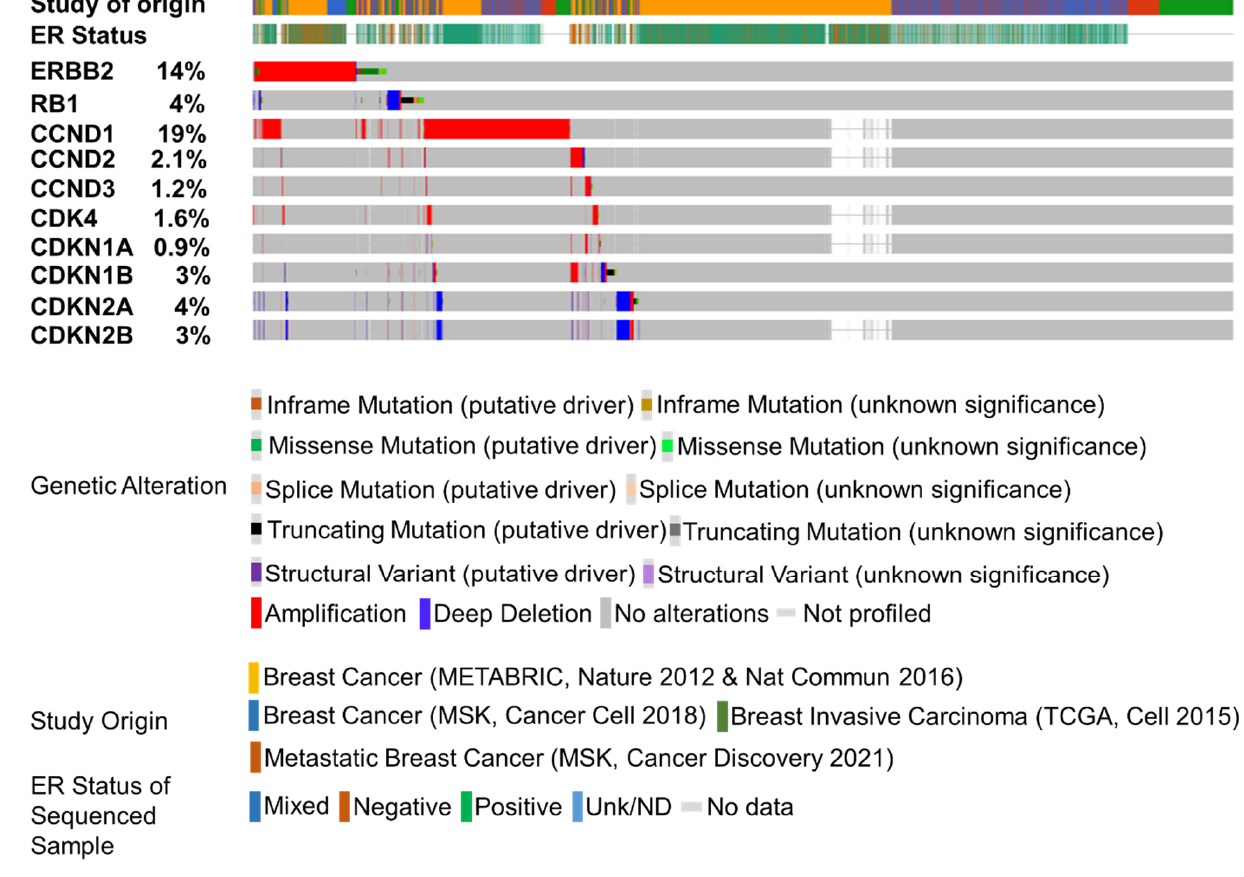
Figure 2. Somatic alterations associated with cell-cycle-related genes in breast cancer genomic datasets. Oncoprint representing the status of 10 genes— ERBB2 , RB1, CCND1 , CCND2 , CCND3, CDK4, CDKN1A , CDKN1B , CDKN2A , and CDKN2B —in 6198 patients/6609 samples in four studies: Breast Cancer (METABRIC, Nature 2021 & Nat Commun 2016) [94,95,97], Breast Cancer (MSK, Cancer Cell 2018) [96], Breast Invasive Carcinoma (TCGA, Cell 2015) [93], and Metastatic Breast Cancer (MSK, Cancer Discovery 2021). Queried genes are altered in 2444 (39%) of queried patients and 2600 (39%)